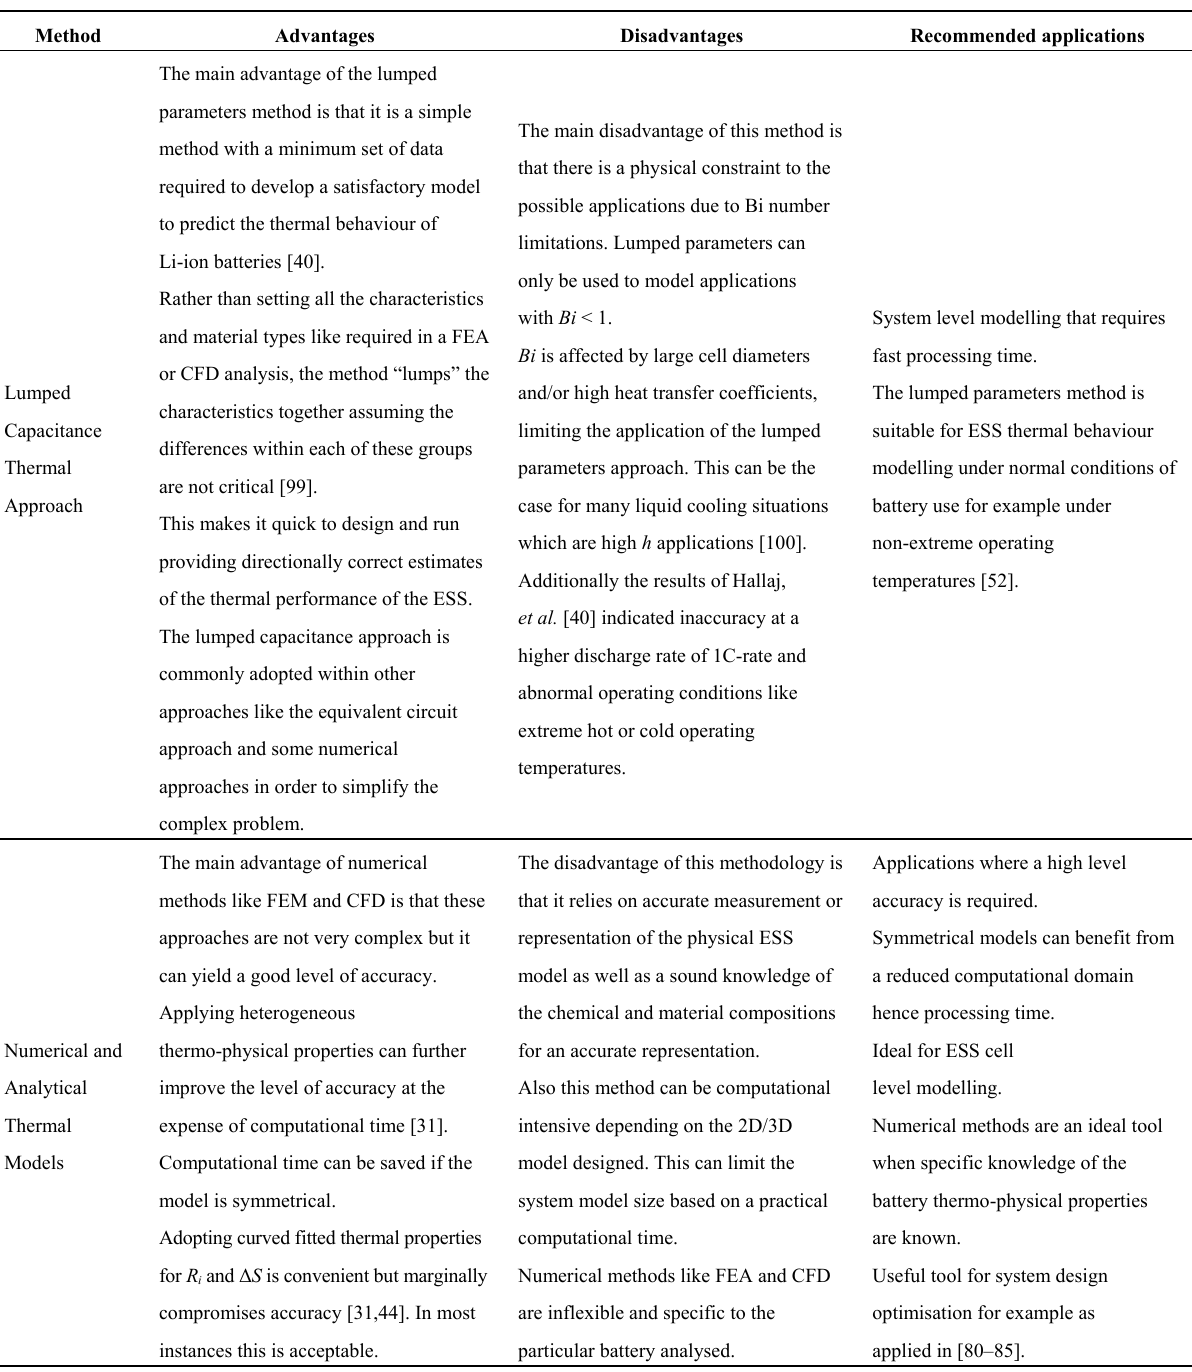
Table 4. Summary of the different thermal modelling approaches for ESS battery